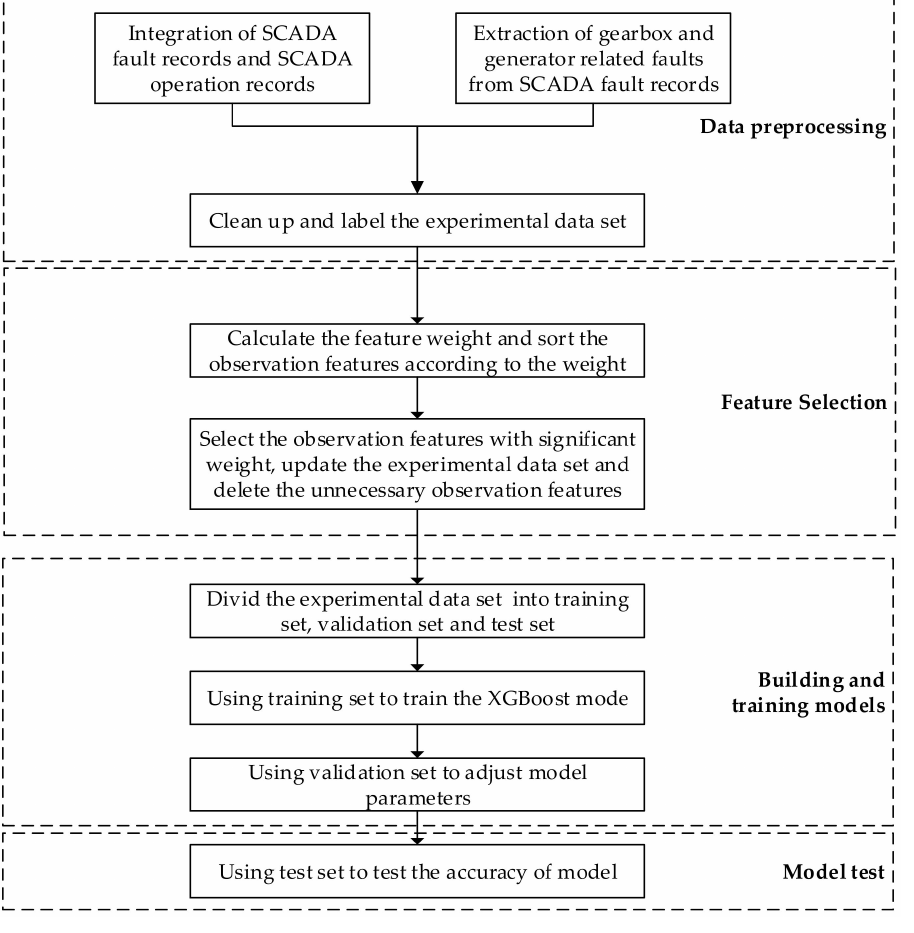
Figure 3. Algorithm flow